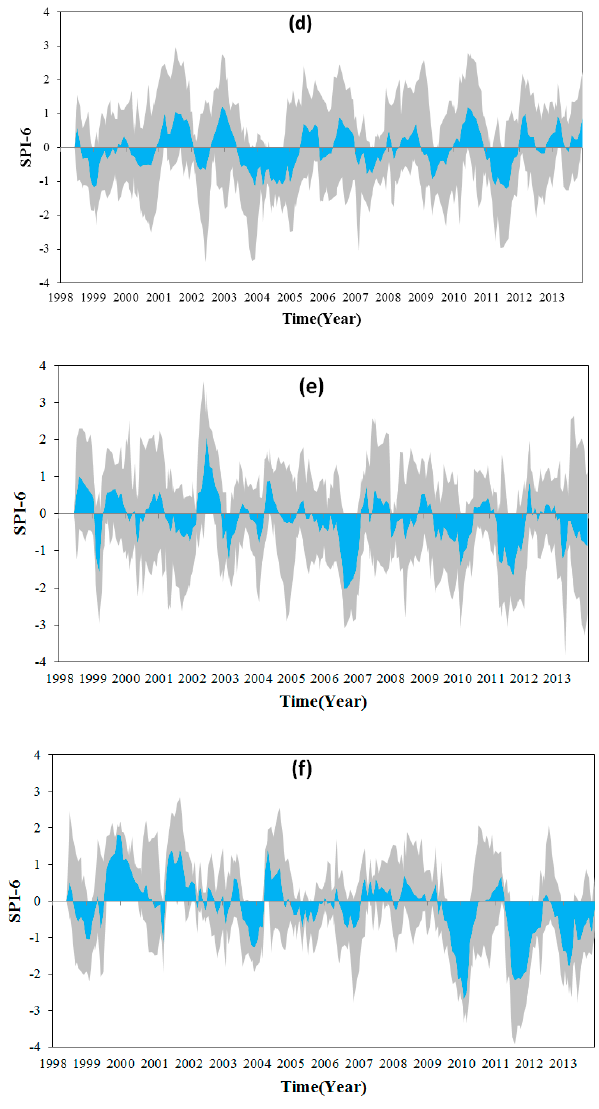
Figure 8. Gauge data for drought monitoring (SPI at time scale of 6 month) for difference regions: ( a ) Northeast, ( b ) Huang–Huai–Hai, ( c ) MLRY, ( d ) South, ( e ) Sichuan basin and ( f ) Southwest.